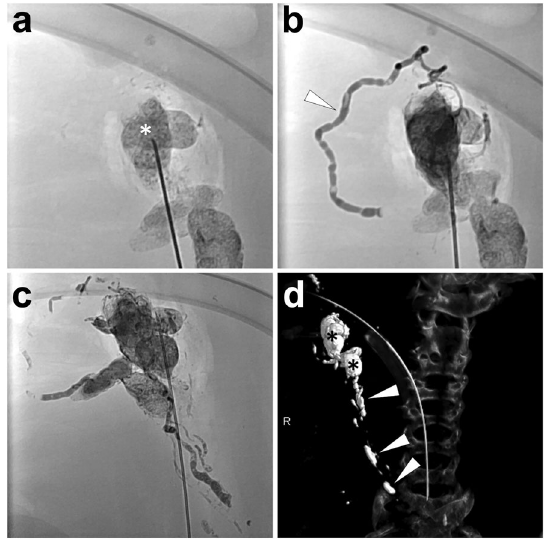
Fig. 9 Illustration of cervical INE under fluoroscopy guidance. After prior lipiodol-based lymphangiography, the target lymph node in the right neck ( * ) was punctured using a 22-gauge Chiba needle under fluoroscopy ( A ). Make the needle tip at the center of the lymph node and remove the stylet; then, inject 1 ml lipiodol through the trocar to confirm the eligible needle position, where the efferent lymphatic vessel ( white arrowhead ) would be gradually visualized but without obvious peripheral extravasation ( B ). After confirmation, inject 4 ml NBCA/lipiodol mixture (1:4) until glue stasis ( C ). Afterwards, the CBCT was implemented to present the spatial details of the embolized lymph nodes ( * ) and efferent lymphatic vessels ( white arrowhead s) ( D ). Images were from Pig No. 10 . Abbreviations: INE, intranodal embolization; NBCA, N-butyl-2-cyanoacrylate; CBCT, cone-beam computed